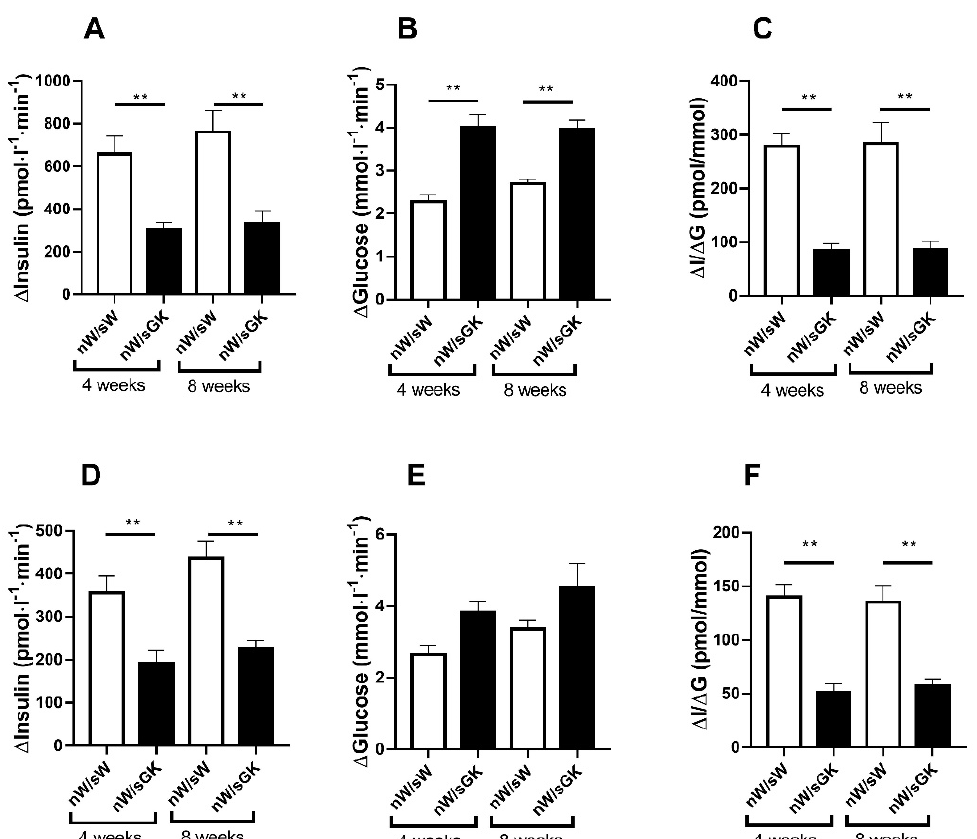
Figure 4. Glucose tolerance ( ∆ G ), glucose-stimulated insulin secretion ( ∆ I ) and insulinogenic index ( ∆ I / ∆ G ) in 4- and 8-wk-old male ( A – C ) or female ( D – F ) rats. Animals were issued from W neonates suckled by GK foster mothers (nW/sGK group) or issued from W neonates suckled by W foster mothers (nW/sW group). In vivo glucose tolerance and insulin secretion were tested in response to an i.p. injection of glucose (1 g/kg body weight) in freely moving rats (post-absorptive state). Values are mean ± SEM. Nine to thirteen rats were analyzed per experimental group. ** p < 0.01 as compared to value in the age- and sex-related nW/sW group. At 8 weeks of age, nW/sGK males had returned to normal body weight. As compared to the nW/sW group, the 8-wk-old nW/sGK males still exhibited normal basal plasma glucose levels, low pancreatic insulin content and low beta cell mass ( p < 0.01) (Table 2 and Figure 5).